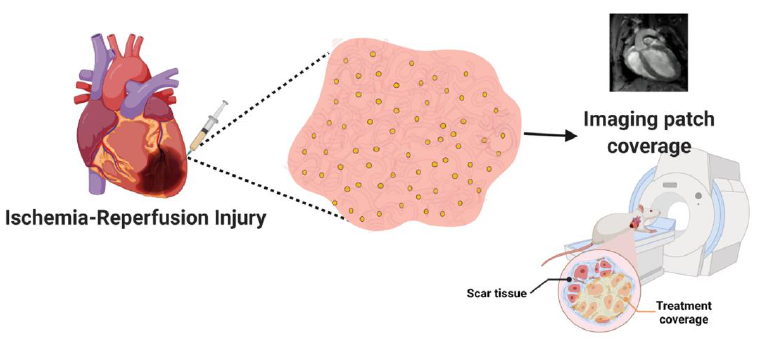
Figure 1. Schematic illustration of the technology. AuNPs are conjugated with Gd and encapsulated within an ECM-based hydrogel. The hydrogel is injected into the left ventricle of mice post ische- mia–reperfusion injury, allowing to determine the location of the treatment in relation to scar tissue in the heart